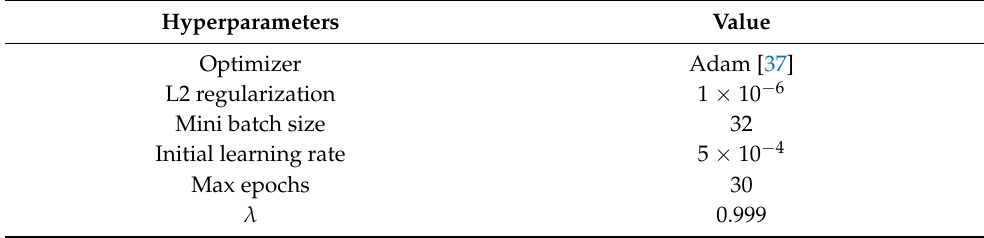
Table 1. Hyperparameters for EMA-RepVGG transfer